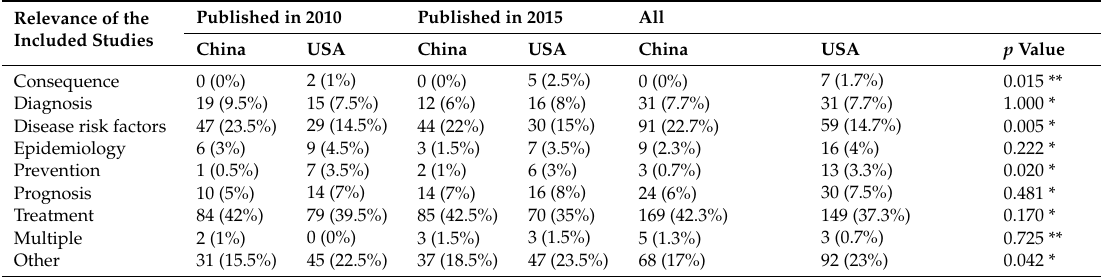
Table 2. Relevance evaluated in the included